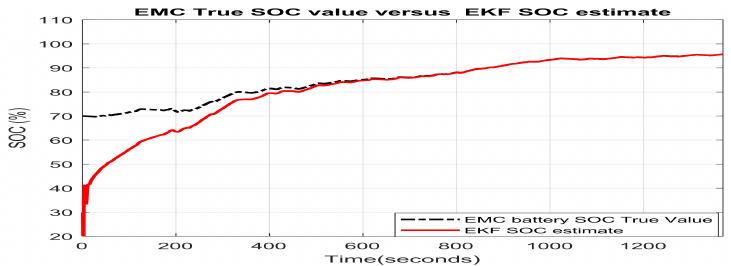
Figure 21. The robustness of EKF SOC estimator to simultaneous changes in SOC initial value and two times increase in internal battery resistance of the Li-Ion